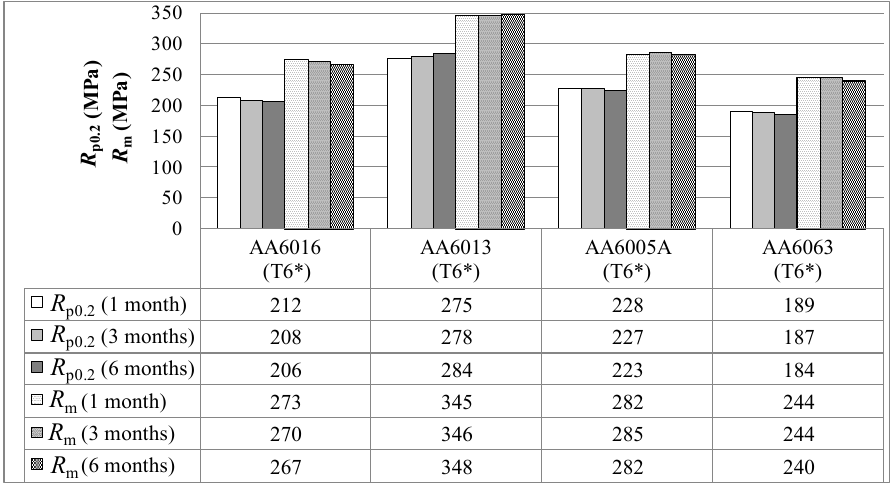
and ultimate tensile strength R p0.2